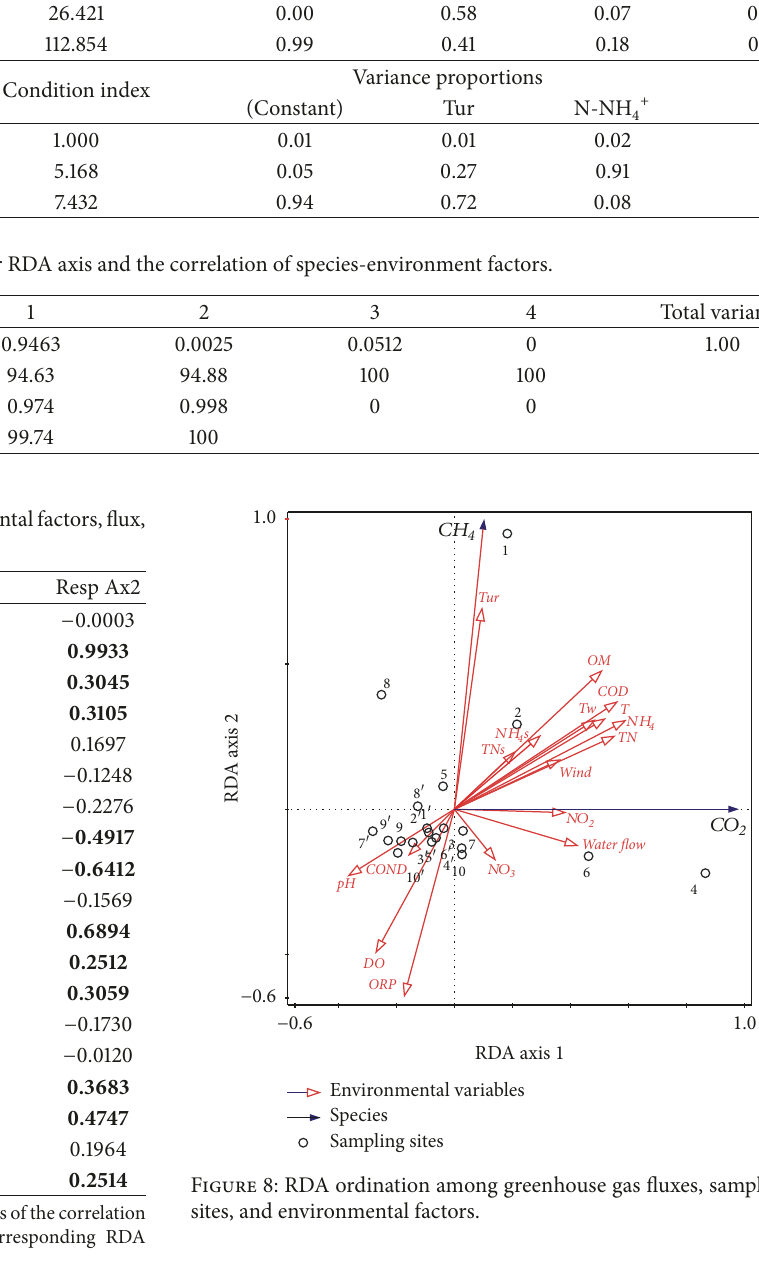
emission (𝑟 = 0.6894) , implying the high turbidity and dark conditions encourage CH 4 formation and